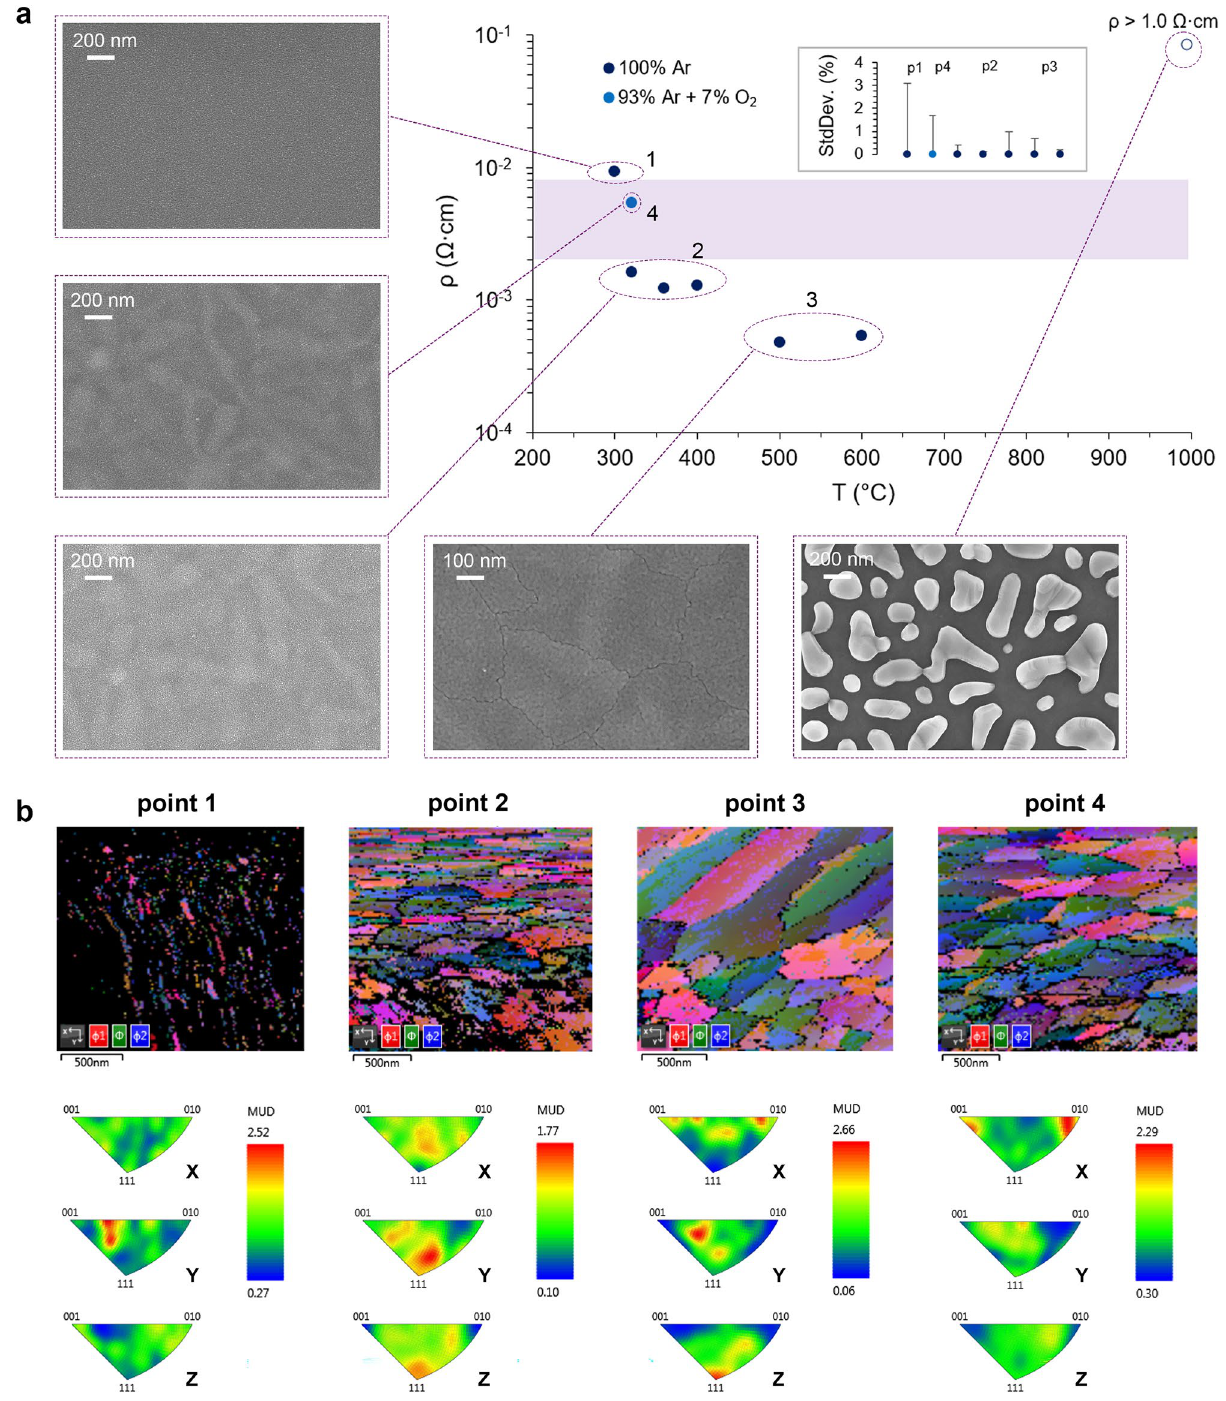
Figure 2. ( a ) 20 nm-thick ITO films [IBAE at room temperature in an Ar/O 2 mixture (4/12 sccm)] resistivity dependency on annealing temperature and atmosphere; high-resolution SEM images of the ITO films surface for each annealing parameters region; resistivity standard deviation error bars are shown for each point of the graphs from left to right correspondingly. ( b ) SEM EBSD analysis for the typical ITO films corresponding to each annealing parameters